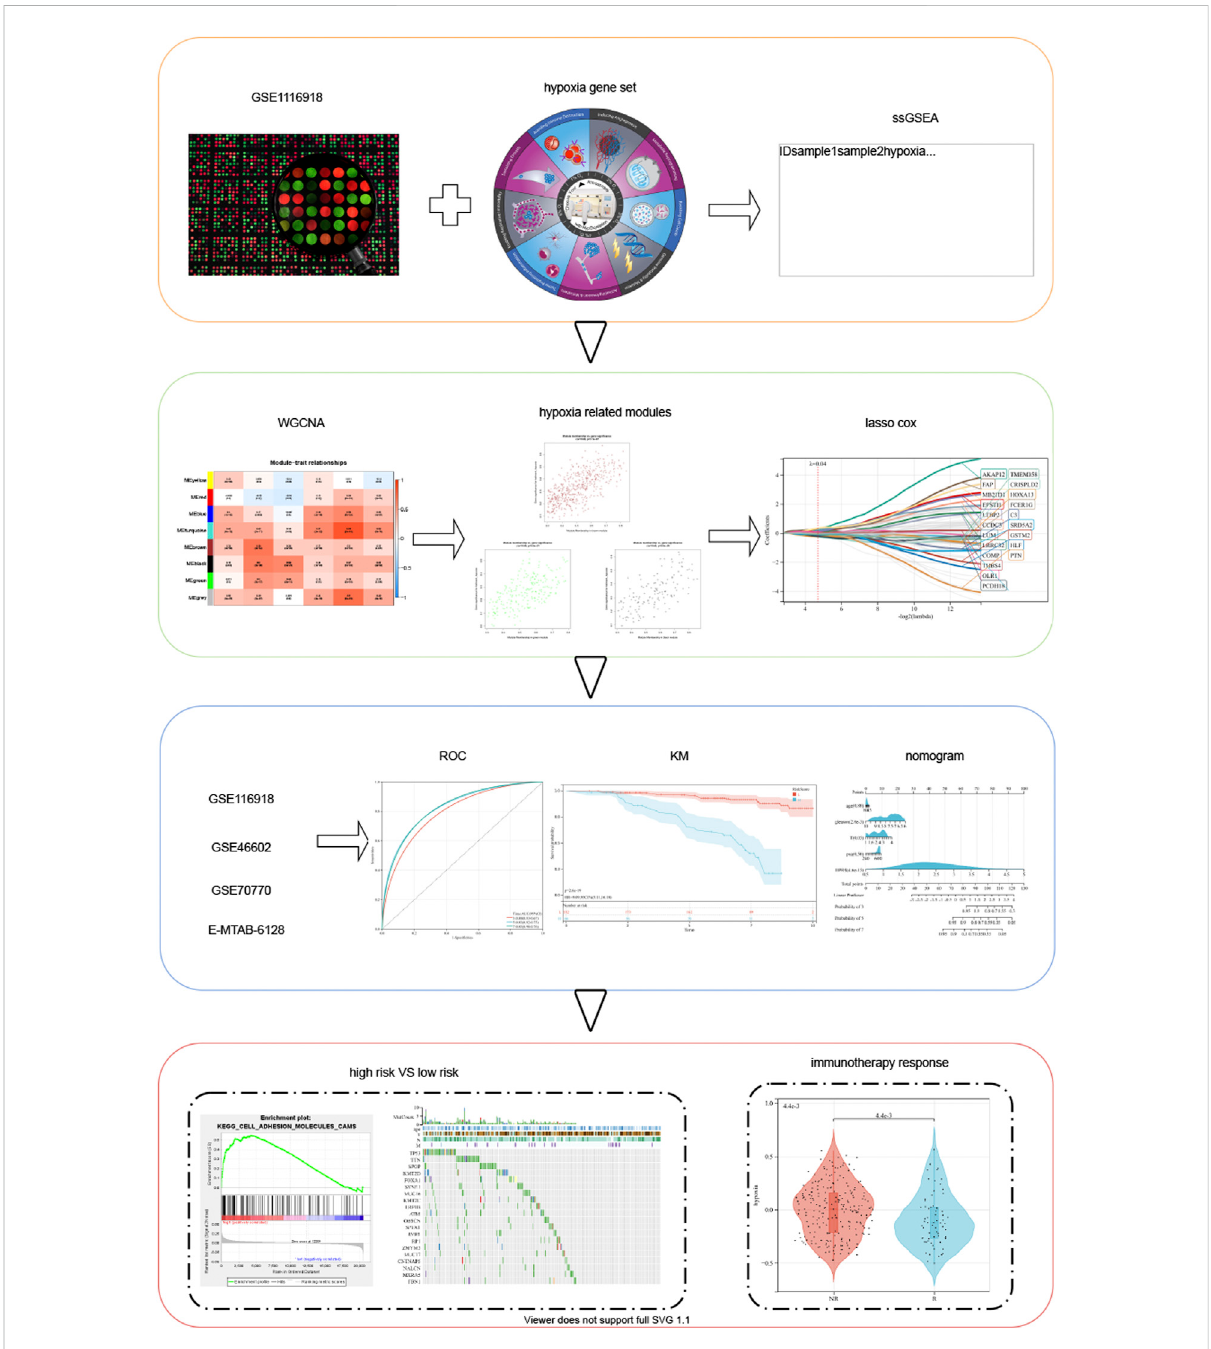
FIGURE 1 Schematic diagram of the study